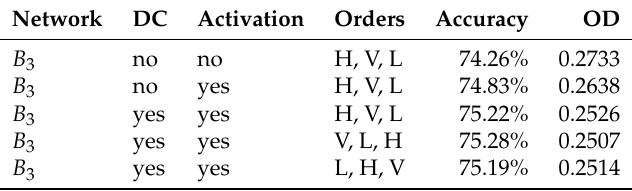
Table 5. Ablation studies for applying Dense Connection (DC) and activation layer (activation for short) in the proposed 3D-DSC. OD: Overfitting Distance. Orders: the orders of separated 1D filters, including H (Horizontal), V (Vertical) and L (Lateral). The batch-size is 4 in this